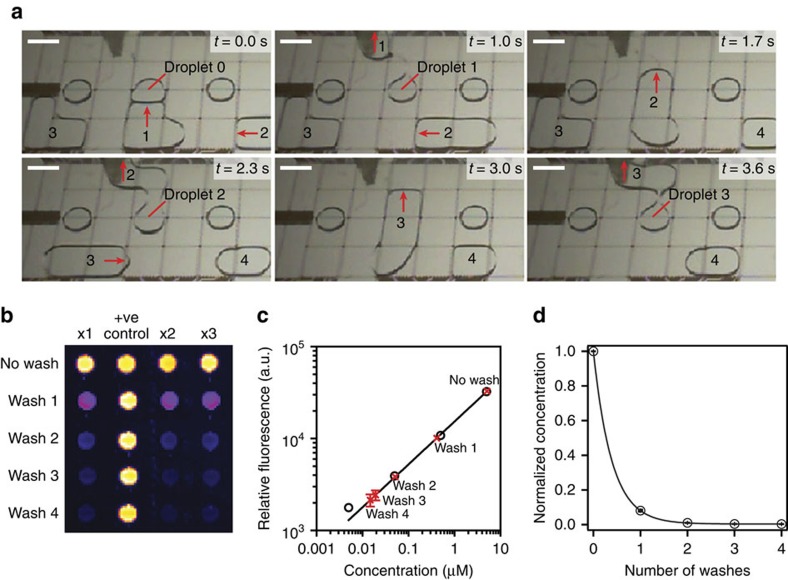
Speed and efficiency of passive dispensing.(a) Time-stamped video sequence from Supplementary Movie 3 depicting passive dispensing of three successive 1.8 μl droplets to a virtual microwell—∼1 s is required between two reagent exchanges. Scale bars, 2 mm. (b) Fluorescent scan of virtual microwells (VMs) initially filled with 5 μM fluosceinamine, washed 0, 1, 2, 3 or 4 times (y-axis) with 1.8 μl droplet(s) of wash buffer (3 technical replicates on the x-axis: x1, x2, x3). (c) Plot of standard curve (open black circles) generated from virtual microwells filled with 5, 0.5, 0.05 or 0.005 μM fluosceinamine overlayed with interpolated data points from VMs washed with 0, 1, 2, 3 or 4 droplets (red crosses). Error bars are ±1 s.d. from x1–x3. (d) Plot showing the efficacy of passive dispensing for removing 5 μM fluoresceinamine from virtual microwells as a function of the number of wash droplets. Error bars are ±1 s.d. from x1–x3.